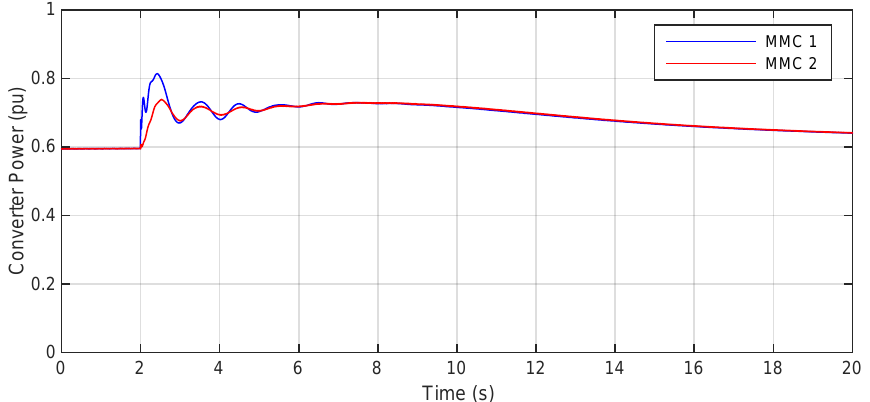
Figure 10. Power injected by the HVDC converter terminals after the disturbance in Scenario